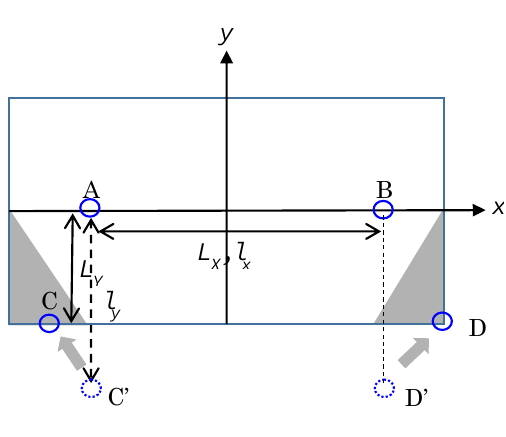
Figure 6 . Projective transformation.